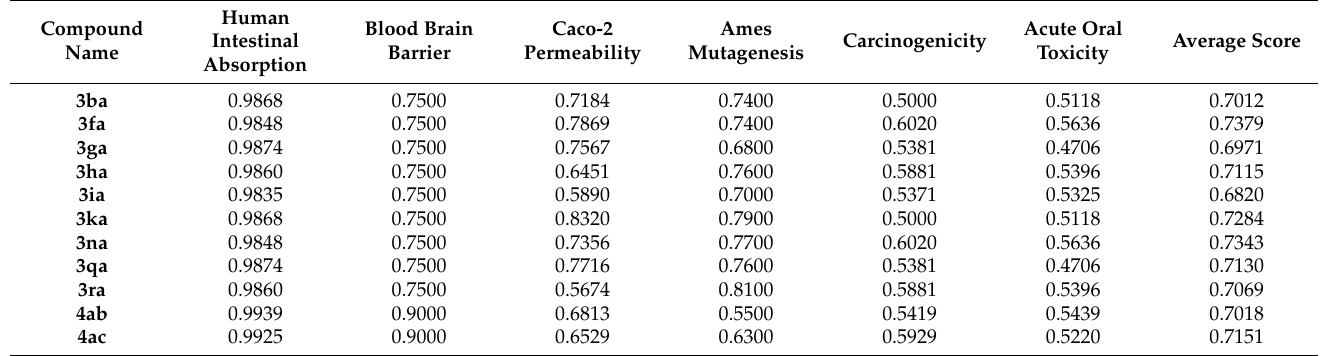
Table 3. ADMET score for human intestinal absorption, Caco-2 permeability, blood–brain barrier, carcinogenicity, Ames mutagenesis and acute oral toxicity, as predicted using